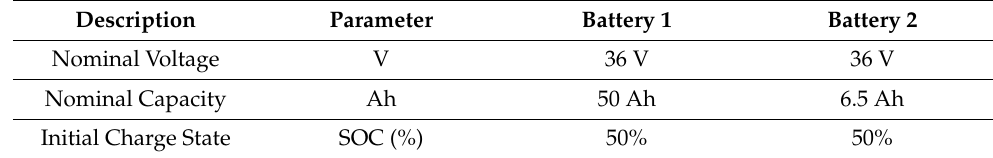
Table 1. Battery 1 and 2